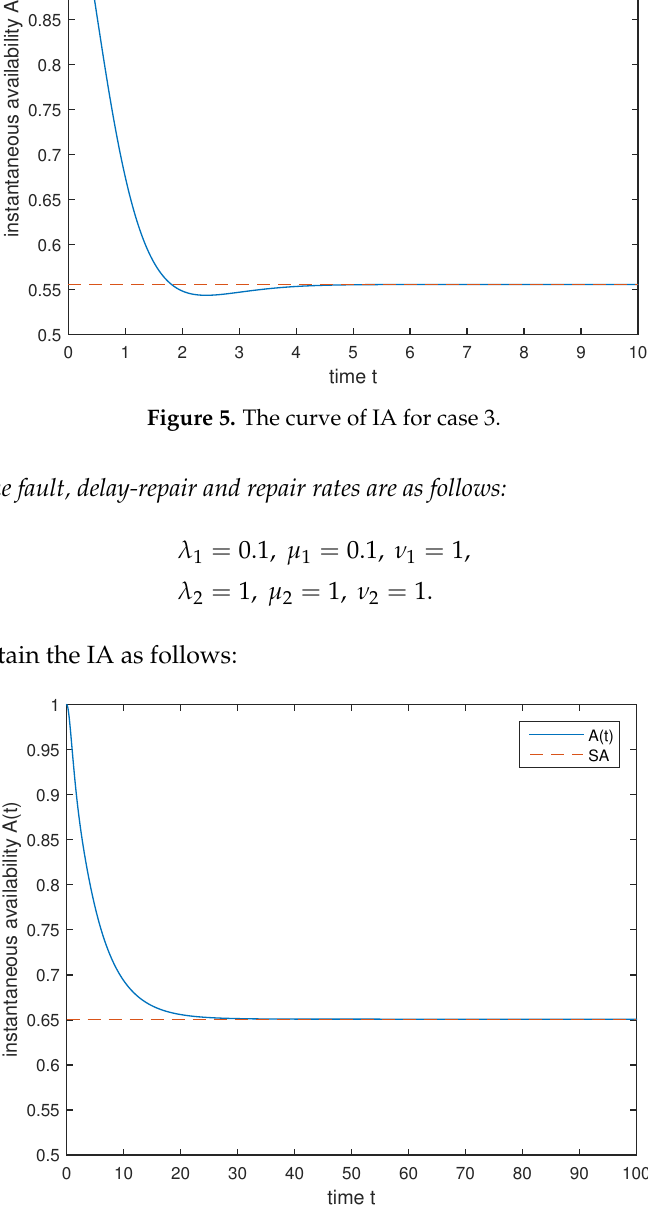
Figure 6. The curve of IA for case